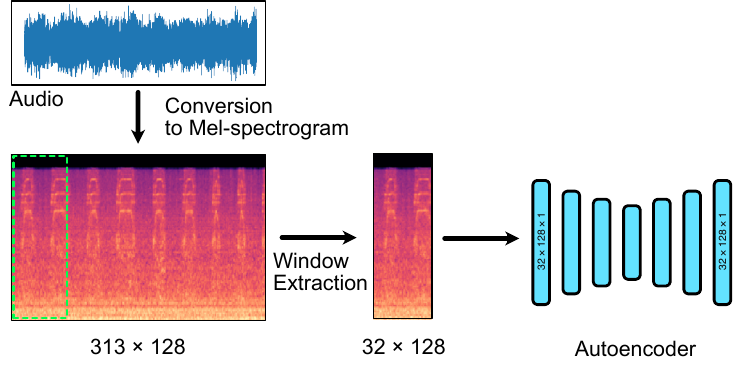
Figure 1. Overview of Mel-spectrogram processing. A given audio signal is transformed to a Mel- spectrogram with 128 Mel bands, hop length of 512 and a Fourier window of 1024. With 10 s of audio, this results in Mel-spectrograms with a size of 313 × 128. Subsequently, we extract nine 32 × 128 pixed sized non-overlapping windows from each Mel-spectrogram. These windows are then fed to an autoencoder for training or for inference. This has the advantage of providing a larger training set and also a smaller image for the autoencoder to